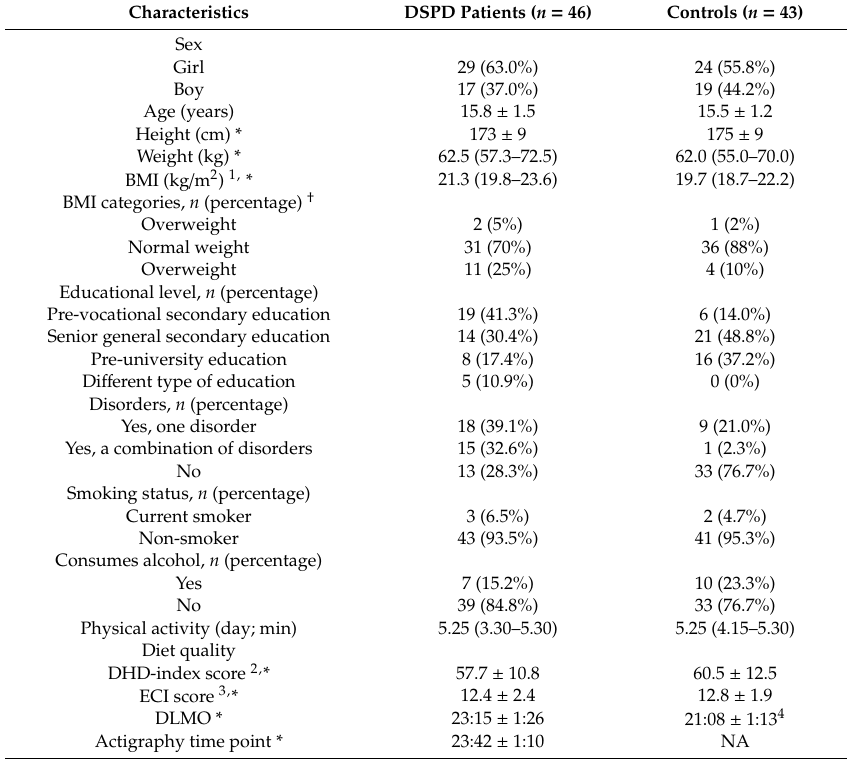
Table 1. Baseline characteristics of delayed sleep-wake phase disorder (DSPD) patients and controls of the Sleep, nUtrition, eating, and delayed Sleep PhasE Disorder iN aDolesecents (SUSPEND) study. Values are presented as mean ± SD, median (interquartile range) or as n